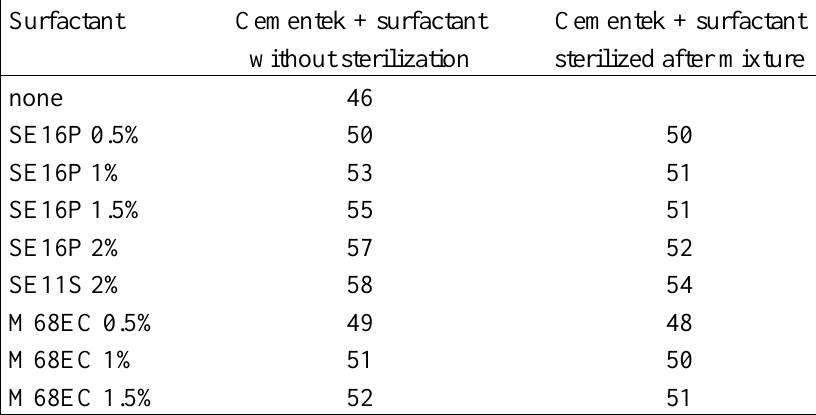
Table 2. Effect of sterilization on porosity